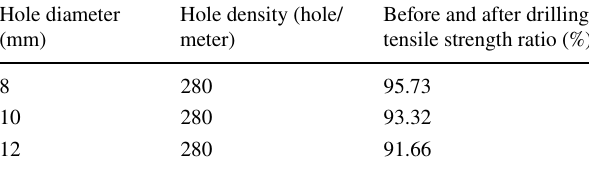
Table 5 Tensile strength of casing after